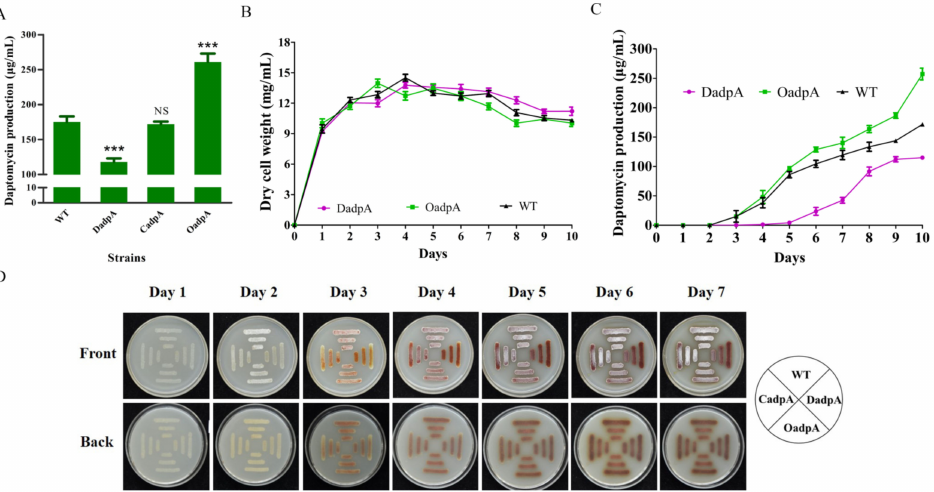
Figure 6. Effects of AdpA on daptomycin and pigment production, cell growth, and morphological development in S. roseosporus . ( A ) Daptomycin production in WT, DadpA, CadpA, and OadpA cultured in fermentation medium for 10 days. NS, not significant; ***, p < 0.001 ( t -test). ( B ) Growth curves for WT, DadpA, and OadpA. ( C ) Daptomycin production curves for WT, DadpA, and OadpA. Error bars in panels ( A – C ): SD for three replicates. ( D ) Phenotypes of WT, DadpA, CadpA, and OadpA grown on DA1 plates at 28 ◦